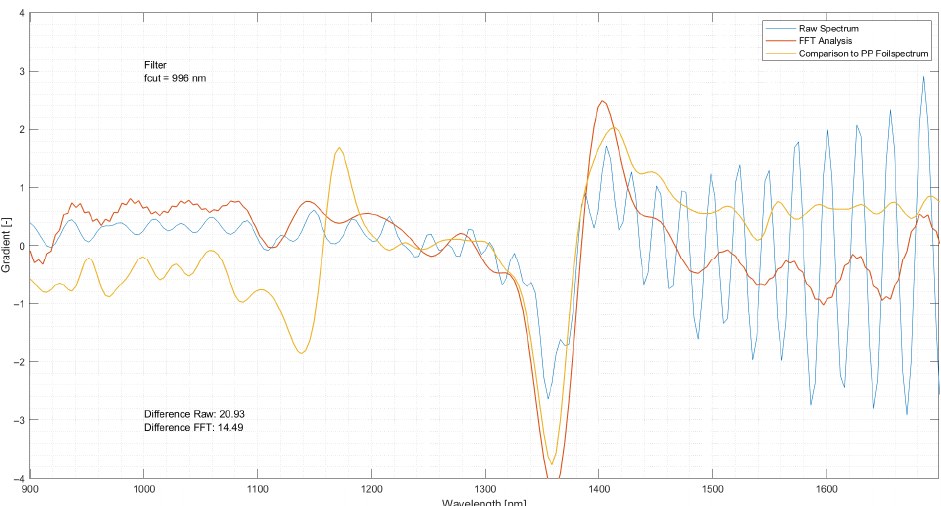
Figure 27. Difference between the raw spectrum (blue) and an improved spectrum (red) and their comparison to a reference spectrum (yellow).